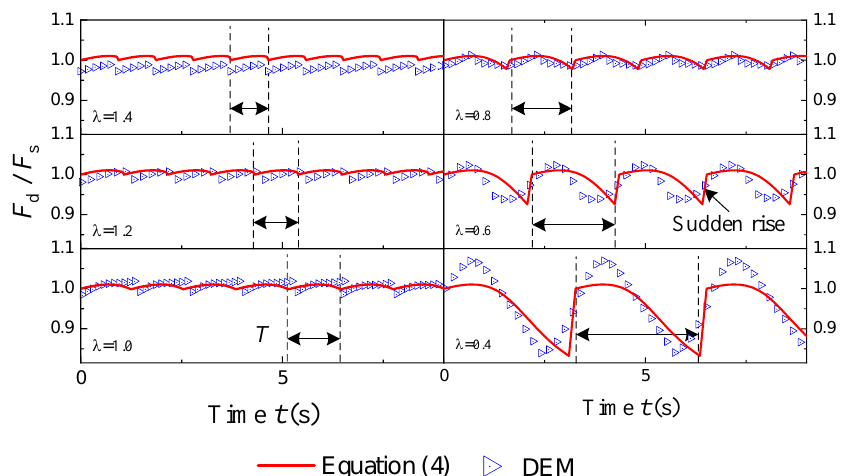
Figure 12. Periodicity of dynamic traction force.